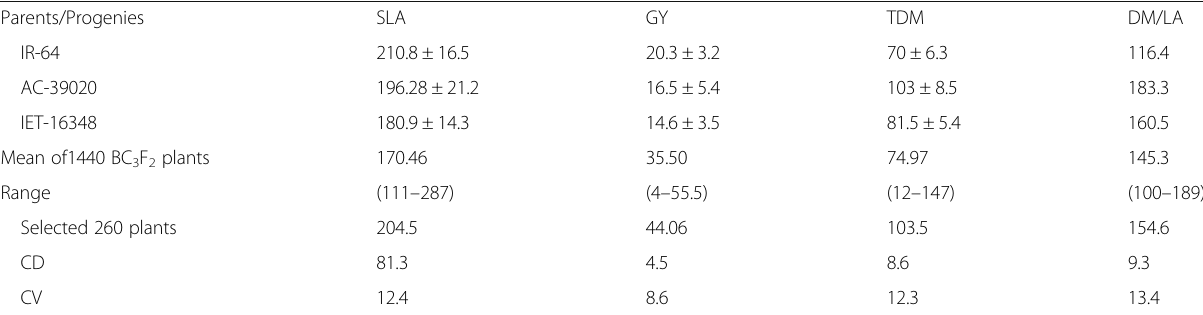
Table 4 Performance of parents and the segregating BC 3 F 2 ( n = 1440) progenies for various morpho-physiological traits under semi- irrigated aerobic condition